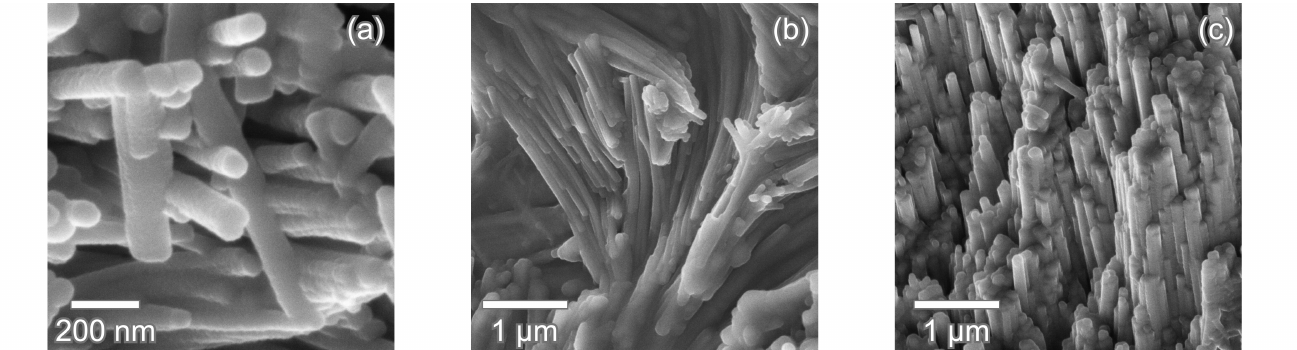
Figure 5. Fluorapatite crystallites in I. oxyrinchus tooth. ( a ) Fracture surface showing individual crystallites. ( b ) The thin, rod-like crystallites change orientation in the TBE (transversal section). Neighboring crystal rods remain parallel. ( c ) Densely packed crystallites within a crystallite bundle (transversal section). The crystallites are aligned parallel to each other and in close contact with each